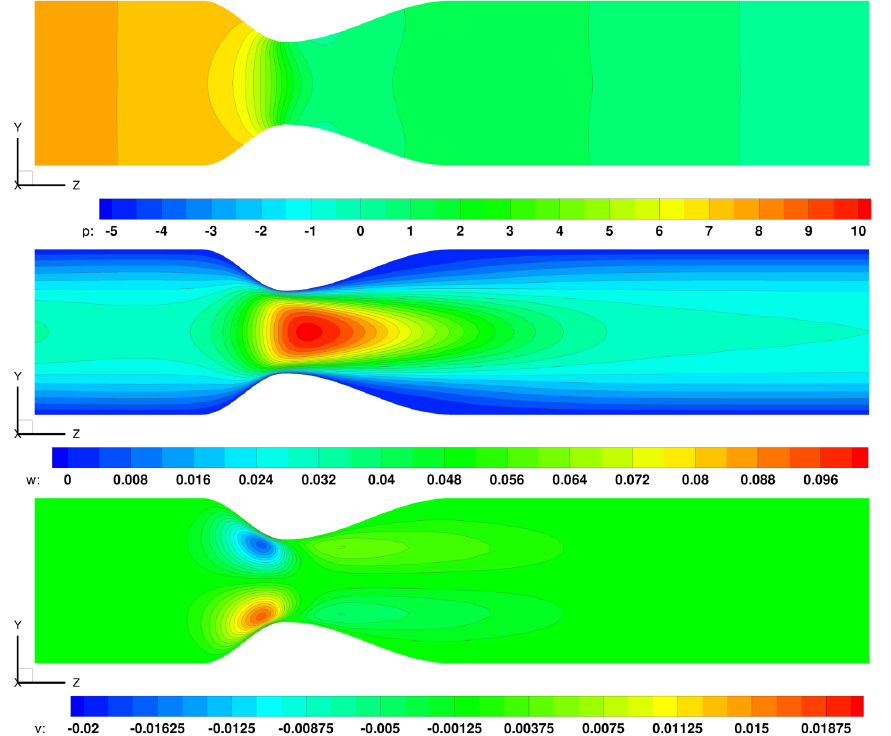
Figure 11. Flow rate Q = 0.5 cm 3 /s—Pressure, axial and radial velocity contours (from the